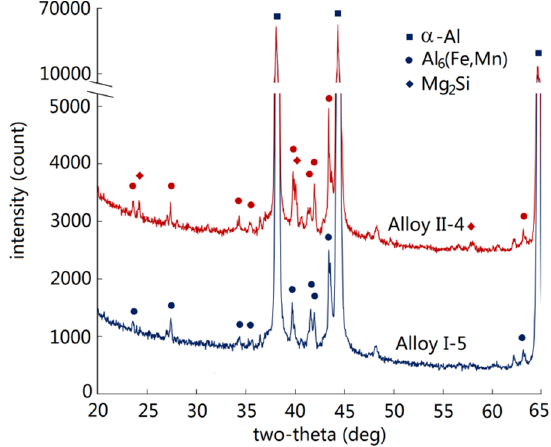
Figure 2. The XRD spectra of Alloy I ‐ 5 and Alloy II ‐ 4.